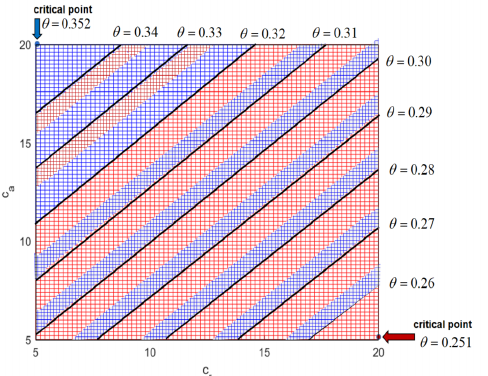
Figure 14. The sample for θ = 0.3 on c r − c a plane with π rn and π an .